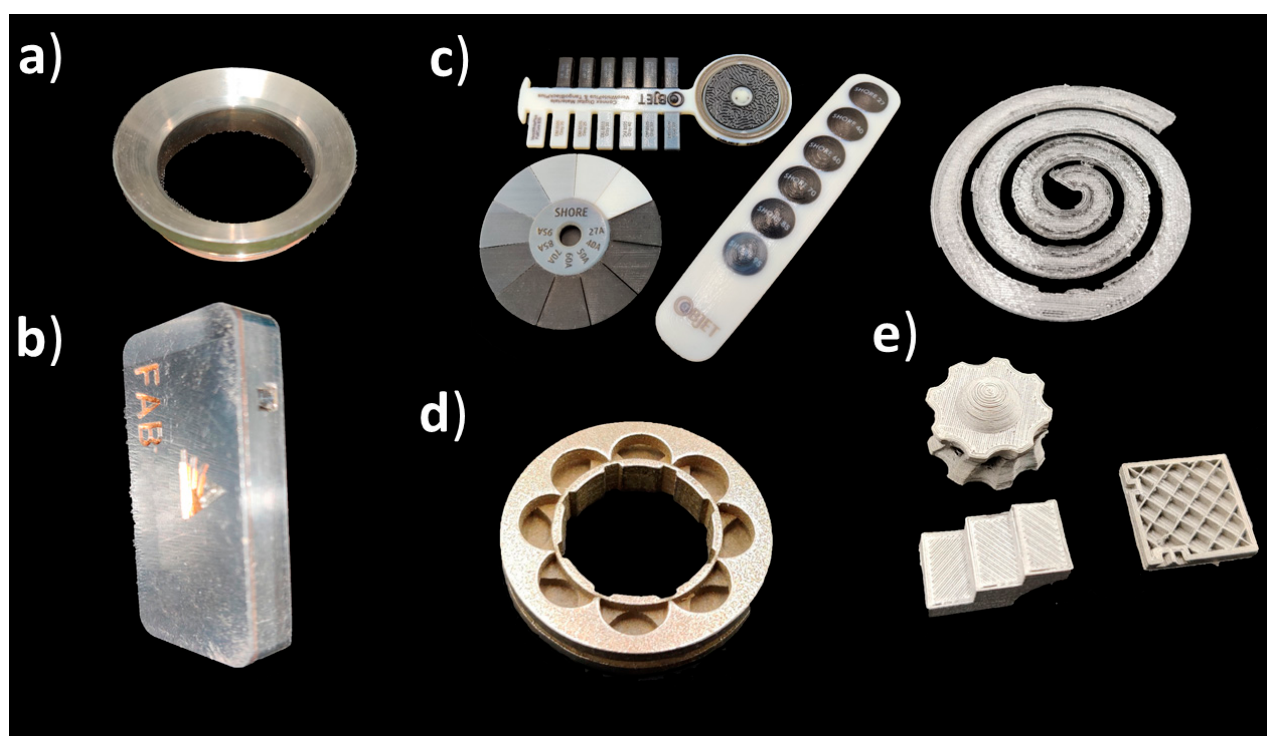
Figure 7. Future possibilities for AM in the medical and dental fields. ( a ) Directed energy deposition repairing, ( b ) multi-material metal parts with sheet lamination, ( c ) multi-material parts with material jetting, ( d ) binder jetting for metal parts, ( e ) material extrusion of metal and composite parts.